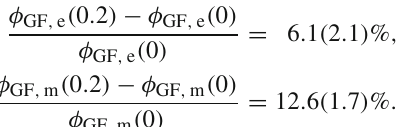
Fig. 2 Comparisonofthe β -functionintheelectric/magneticschemeswiththeirperturbativepredictions.Wealsoshowtheperturbativepredictions in the GF infinite volume and MS schemes. The shaded region corresponds to the range where the data is available ¯ g 2 ∼ [ 1 , 2 . 5 ] . See text for a